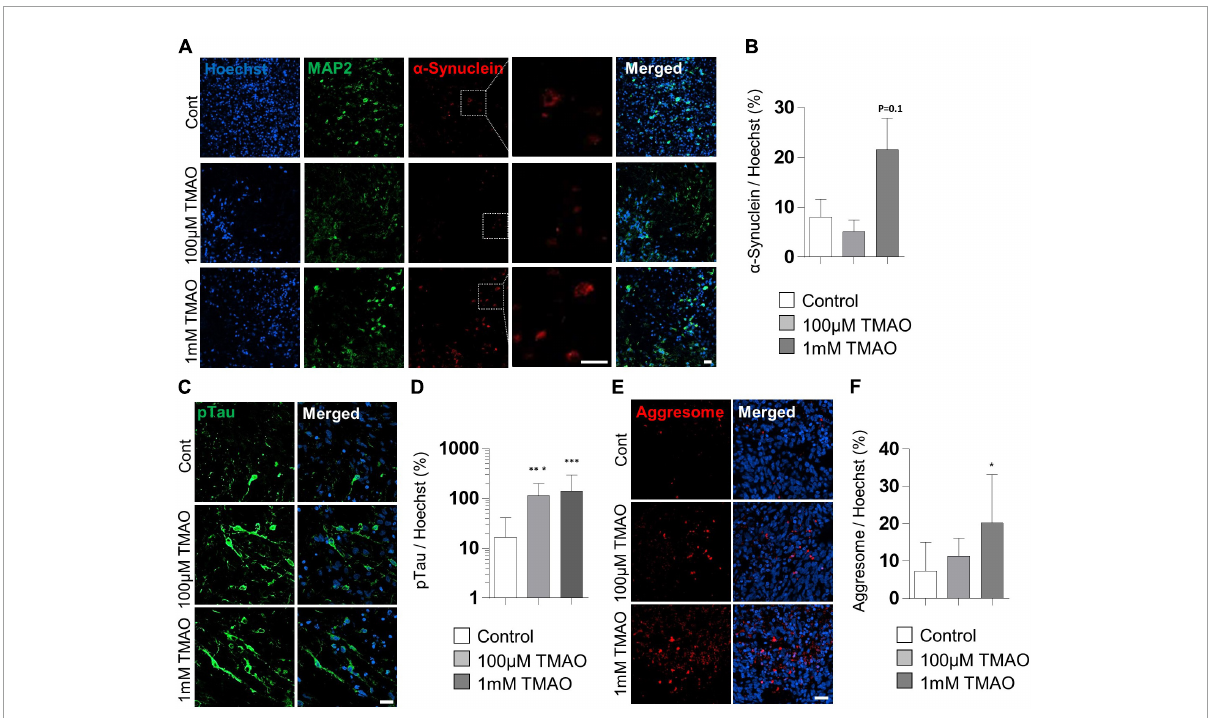
FIGURE5 Parkinson’s disease (PD)-associated phenotypes in trimethylamine N -oxide (TMAO)-treated midbrain organoids. (A) Representative IF images showing the microtubule-associated protein 2 (MAP2) and phosphorylated α -synuclein (ser129) in the indicated organoids (30WMs). (B) Quantification of phosphorylated α -synuclein (ser129) accumulation in neurons. (C) Representative IF images showing the phosphorylated-Tau (ser202/thr205) in the indicated organoids (30WMs). (D) Quantification of pTau accumulation in indicated organoids. (E) Representative IF images showing the aggresome in the indicated organoids (30WMs). (F) Quantification of aggresome in indicated organoids. Data are AVE ± SD [ P < 0.05(*), P < 0.01(**), P < 0.001(***)]. (Scale bar = 20 µ